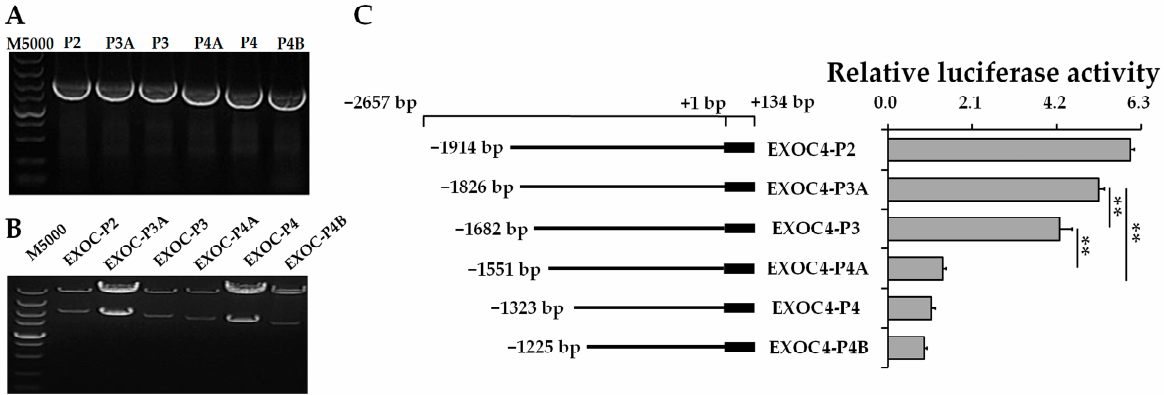
Figure 6. Transcription activity of the P2-P4 region of EXOC4 . ( A ) PCR products of smaller 5 ′ deletion fragments from the promoter of EXOC4 ; ( B ) enzyme digestion identification of pGL3-vector with a further deletion fragment of the EXOC4 promoter; ( C ) the relative luciferase activity of a smaller 5’ deletion fragment on the EXOC4 promoter. M5000: DNA marker of 5000 bp. ** indicates p < 0.01. Data are presented as means ± SD.